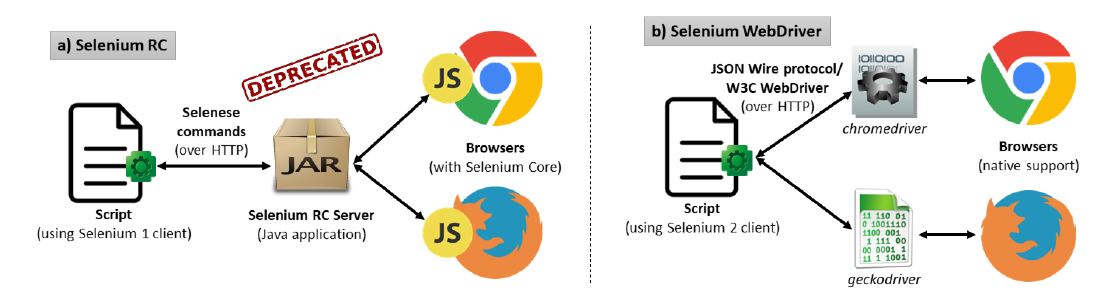
Figure 1. Selenium Remote Control (RC) and Selenium WebDriver architecture.